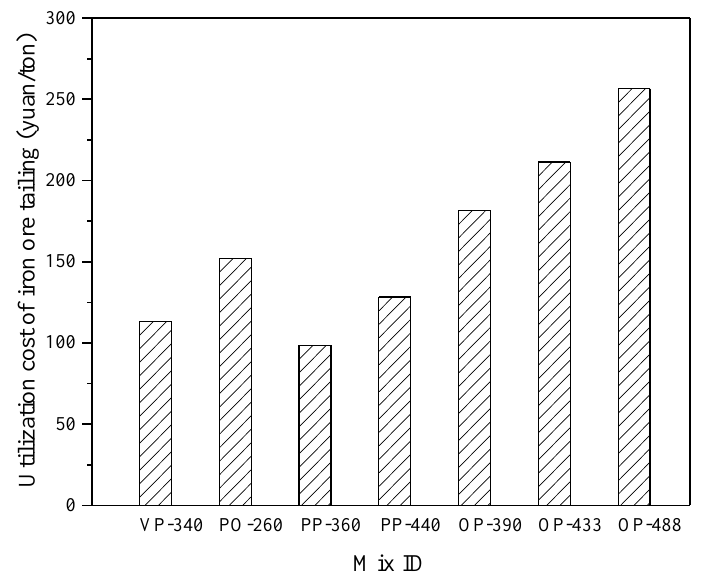
Figure 9. Comparison of utilization cost of unit IOT.